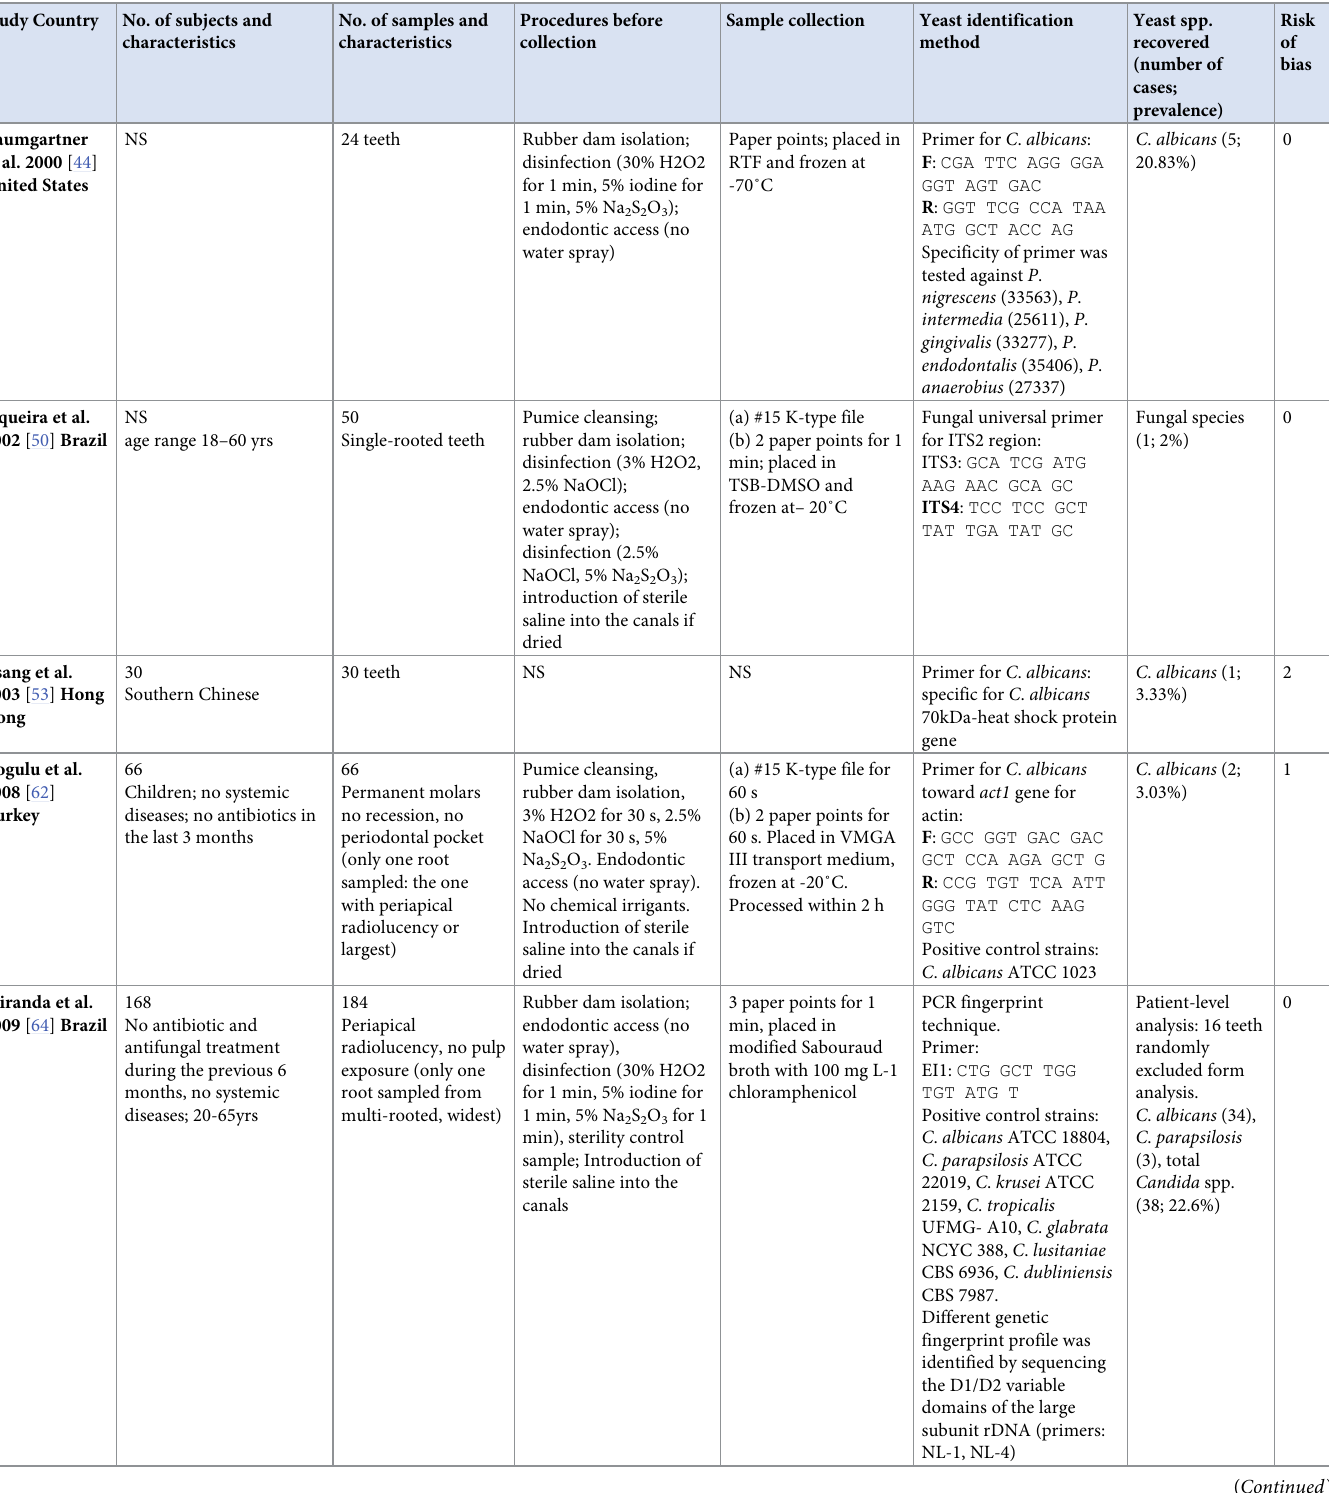
Table 4. Characteristics of the included studies using molecular methods for assessing fungal presence in teeth with primary endodontic infection. Study Country No. of subjects and